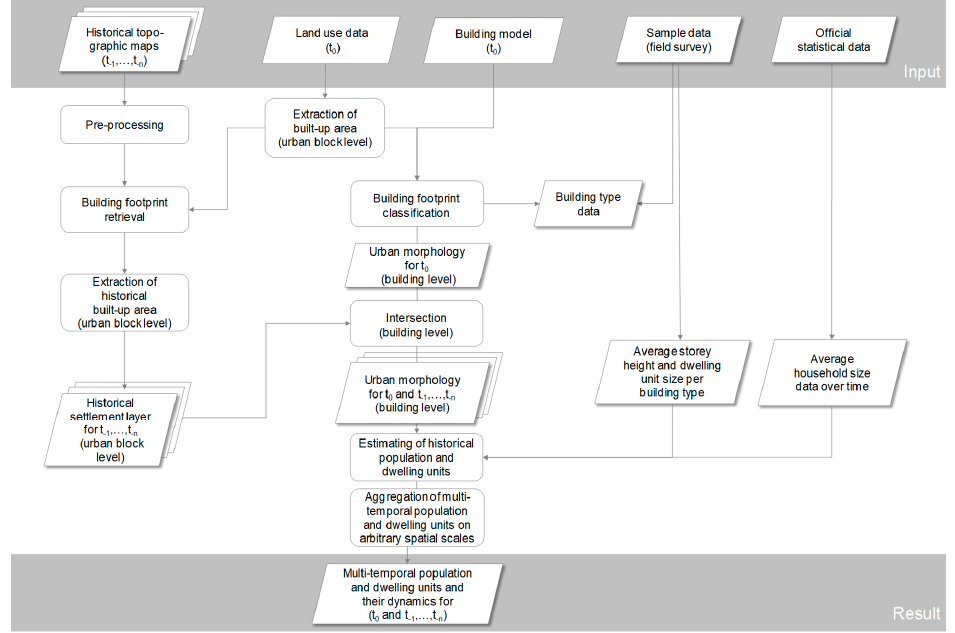
Figure 1. Methodological framework and processing steps.